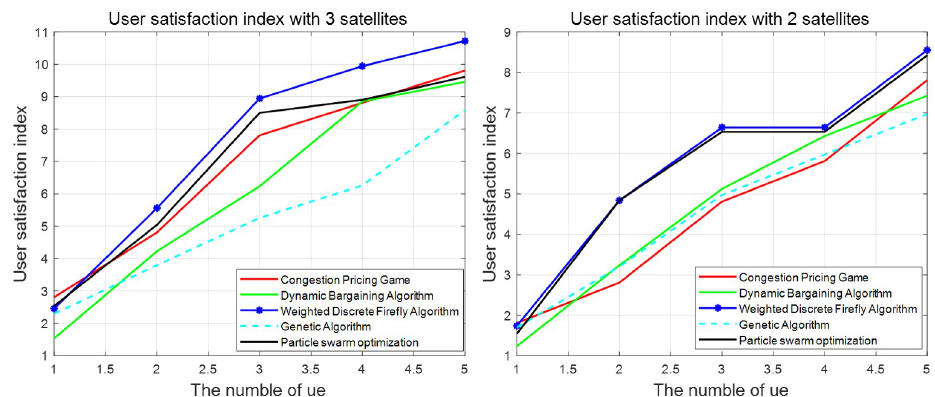
Figure 13. The user satisfaction index of the different number of users with the different number of satellites using different